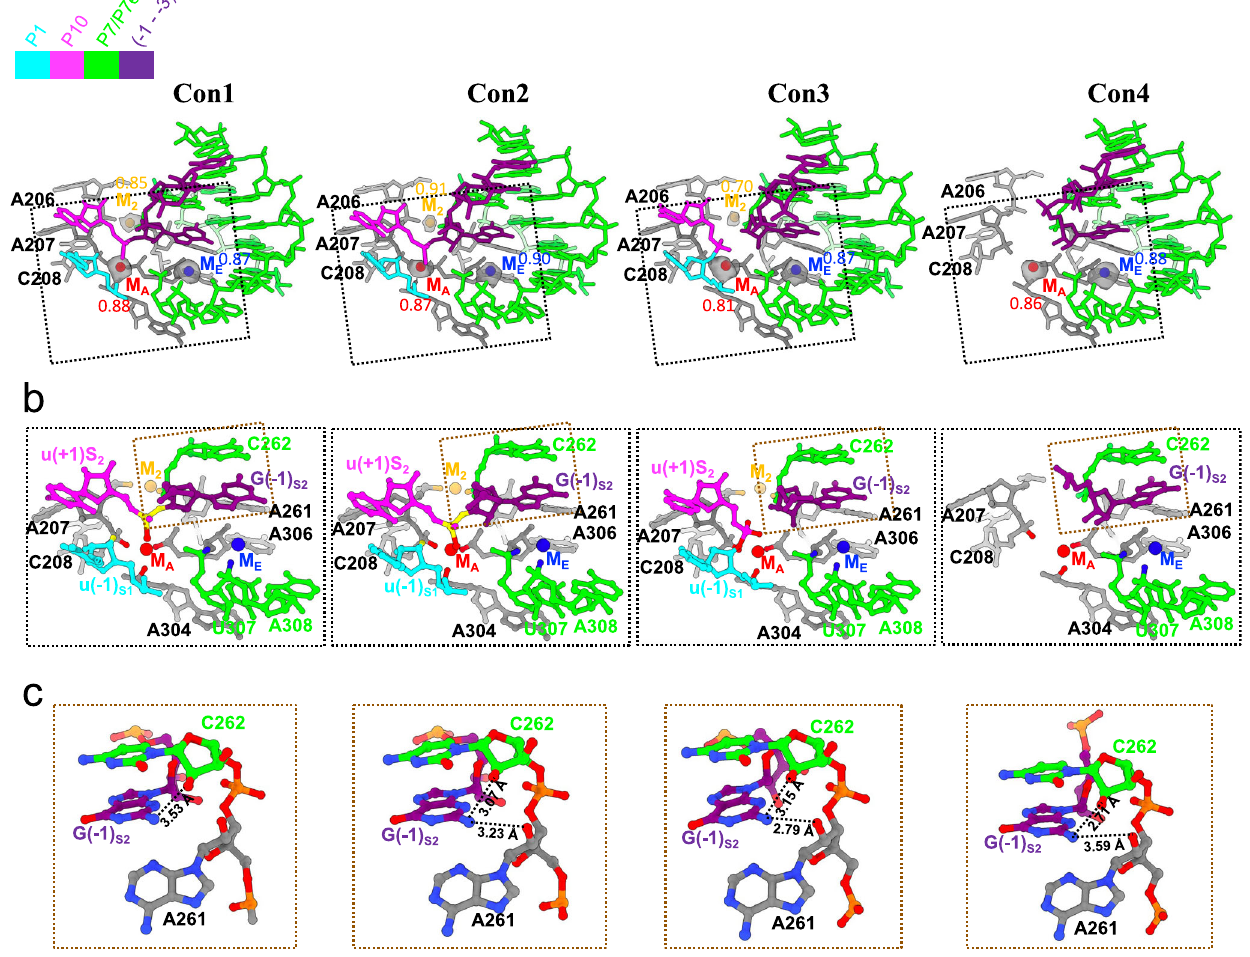
Fig.5|Comparisonofactivesitesamongdifferentsplicingstates.a Overviewof the active site with critical metal ions in Con1-4. The active sites of Con2-4 were aligned with reference to that of Con1. The metal ions are displayed in cryo-EM densities with the models fi tted and Q-scores indicated. b Coordination of critical